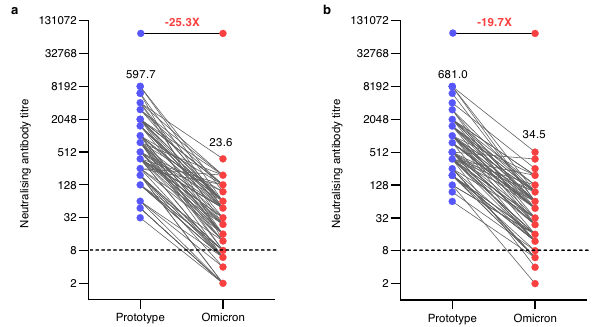
Cohort2, 3.0 μ g group ( n =82).Dots are reciprocal neutralising antibody titres for individuals in the per-protocol population. Numbers above the dots are GMTs. Numbers above the short horizontal lines are reduction folders of cross- neutralisation comparisons between prototype and Omicron. The dotted hor- izontal line represents the seropositivity threshold (1:8). Titres lower thanthe limit of detection (1:4) are presented as half the limit of detection. GMT geometric mean titre.